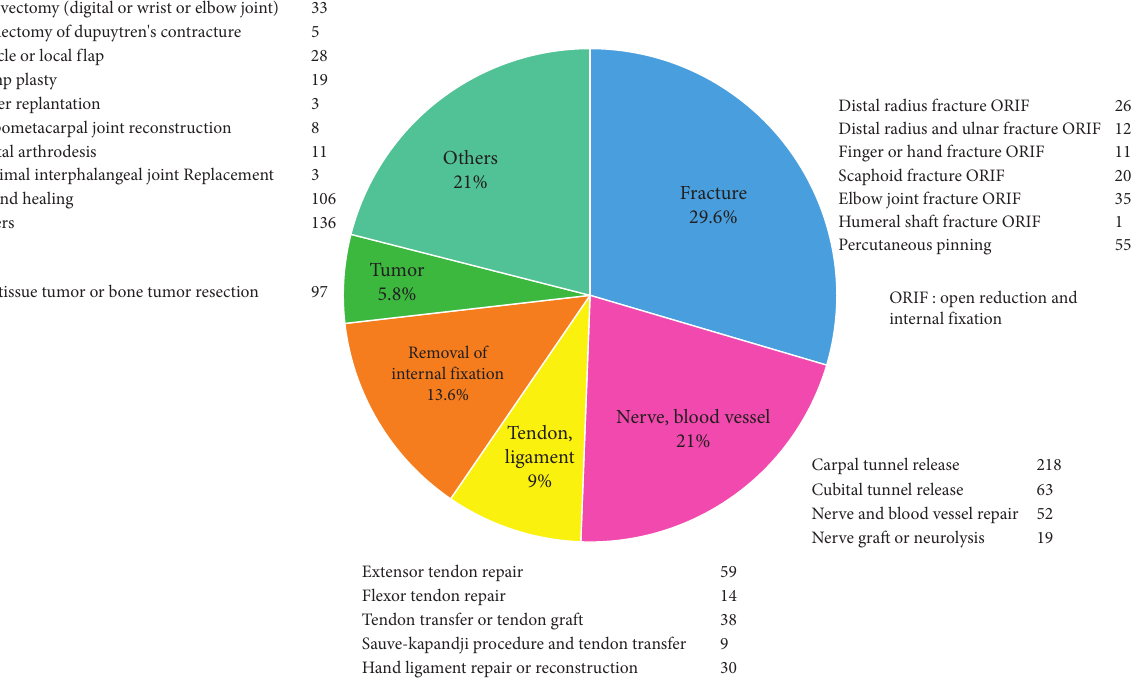
Figure 1: The types of 1,674 upper extremity surgery cases under ultrasound-guided peripheral nerve blocks.